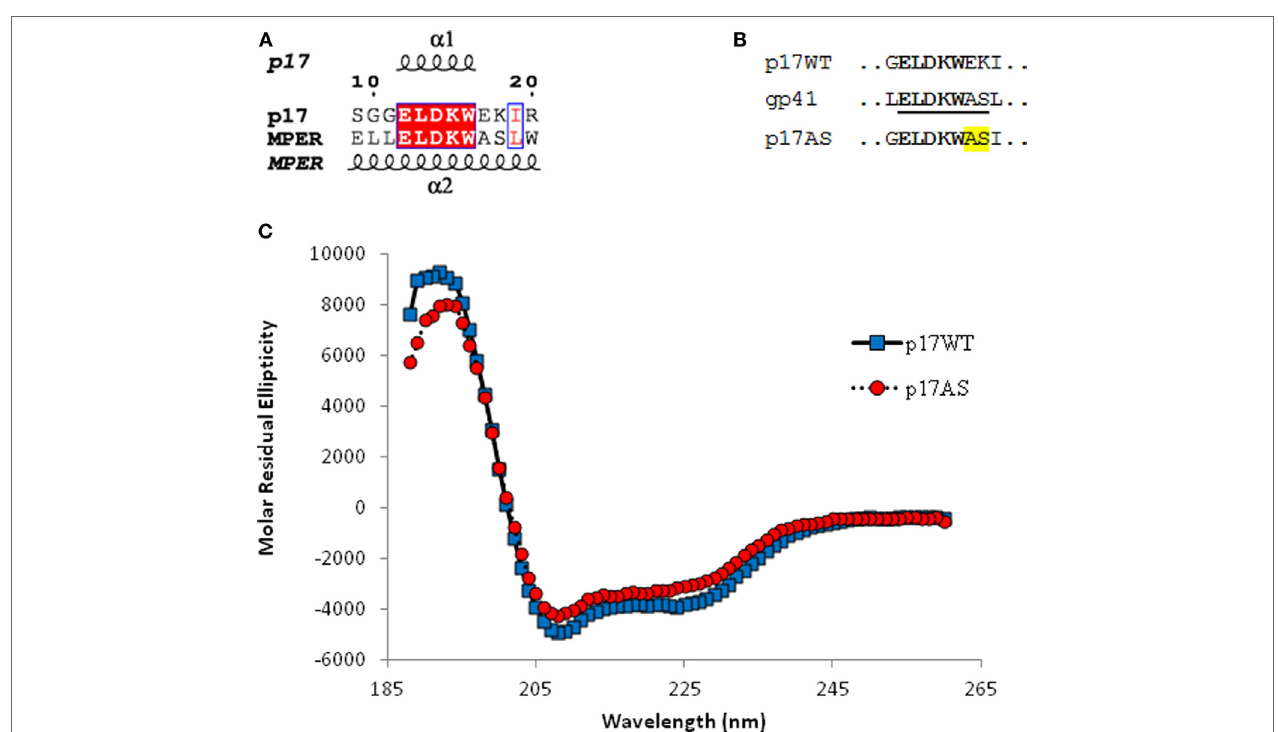
FigUre 1 | Design and characterization of p17AS mutant. (a) Partial alignment and structural environment of the amino acid sequences of p17 residues 9–20 and the membrane proximal external region (MPER) region of gp41 residues 661–672 [numbering according to the pNL4-3 Gag polyprotein and HXB2 Env sequences, respectively (27)]. Identity and similarity are depicted by red and empty boxes, respectively. Secondary structures are extracted from PDB ID 1HIW (28) for p17 and PDB ID 5IQ7 (29) for MPER. Rendering was performed using the ESPript server http://espript.ibcp.fr (30); (B) partial alignment of the amino acid sequences of p17WT and gp41 around the shared pentapeptide ELDKW (in bold) with the mutant p17 (p17AS). Underlined is the 2F5 epitope in gp41. The p17AS mutation is highlighted in yellow; (c) far UV circular dichroism spectra obtained for wild-type (blue squares) or p17AS mutant (red circles).